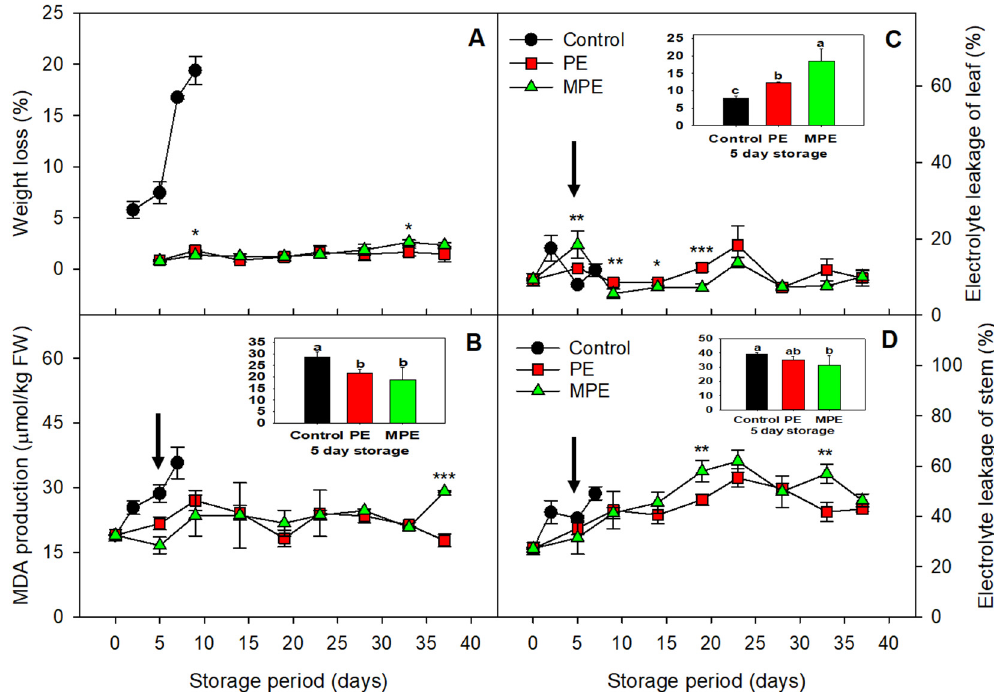
Figure 1. Weight loss ( A ), MDA production ( B ), electrolyte leakage of leaf ( C ), and electrolyte leakage of stem ( D ) of G. littoralis during storage at 4 °C. MAP treatment was classified into micro-perforated PE (MPE, 32 pinholes) and PE on the basis of the presence or absence of pinholes, respectively. Values are shown as mean ± standard deviation. Statistical significance was shown by a t -test between PE and MPE at each time point during storage (*** p < 0.001, ** p < 0.01, and * p < 0.05). The arrow indicates ( B – D ) the time point after 5 days of storage and the statistical analysis of each value between the control and MAP treatment is displayed as a bar graph in the inner box. The different letters represent the significant differences by Fisher’s least significant difference (LSD) test; p < 0.05.